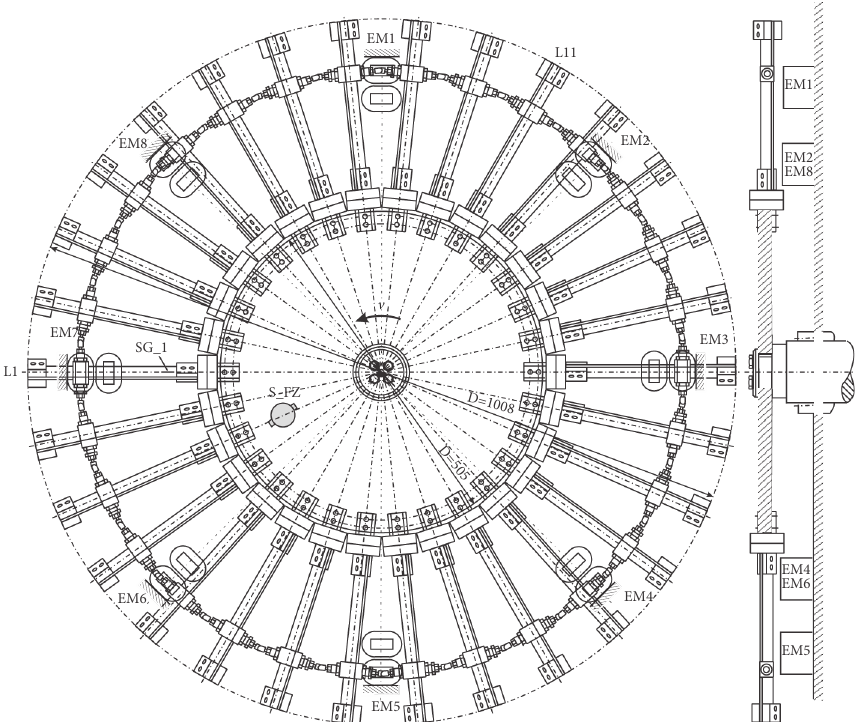
Figure 5: Schematic of the test rig of the bladed wheel. Table 1: Results of modal analysis of the bladed wheel for open contacts (FEM, experiment).